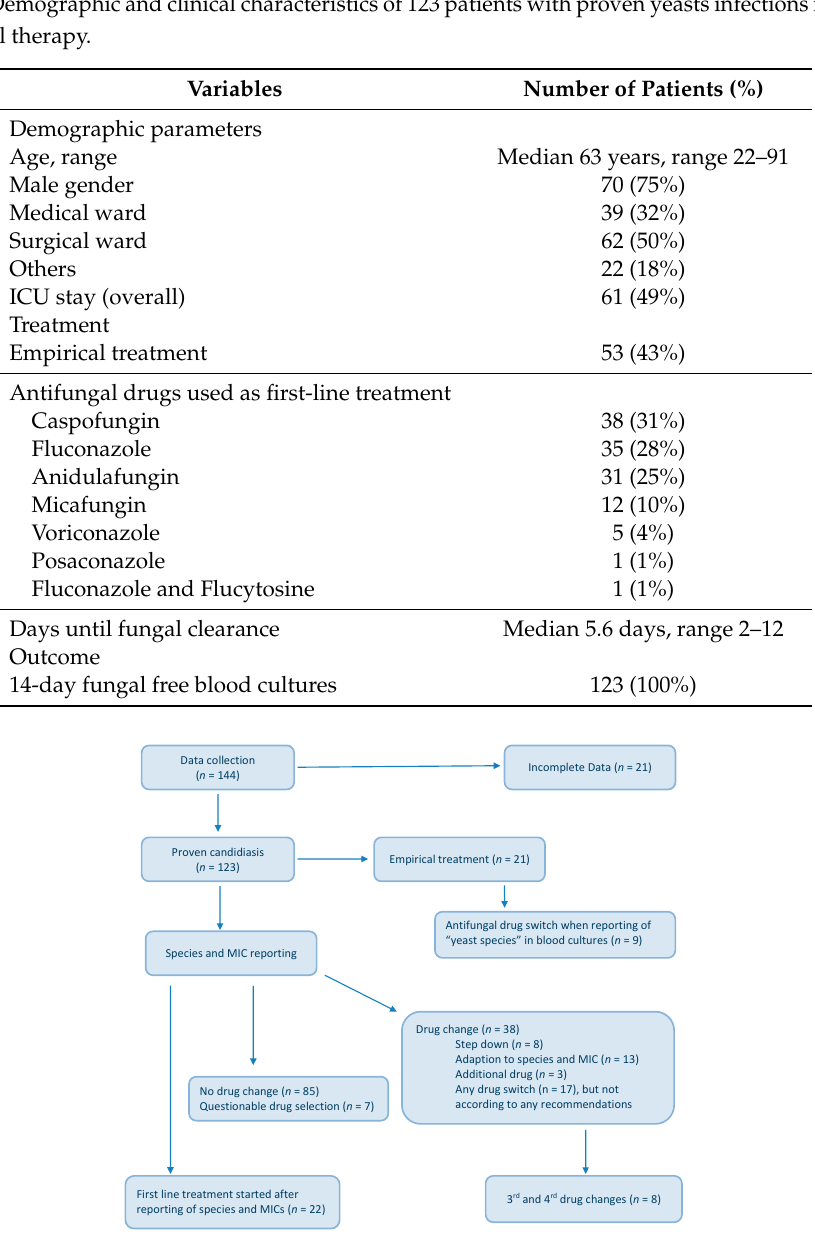
Figure 1. Flow chart of patients with proven candidiasis and antifungal treatment .